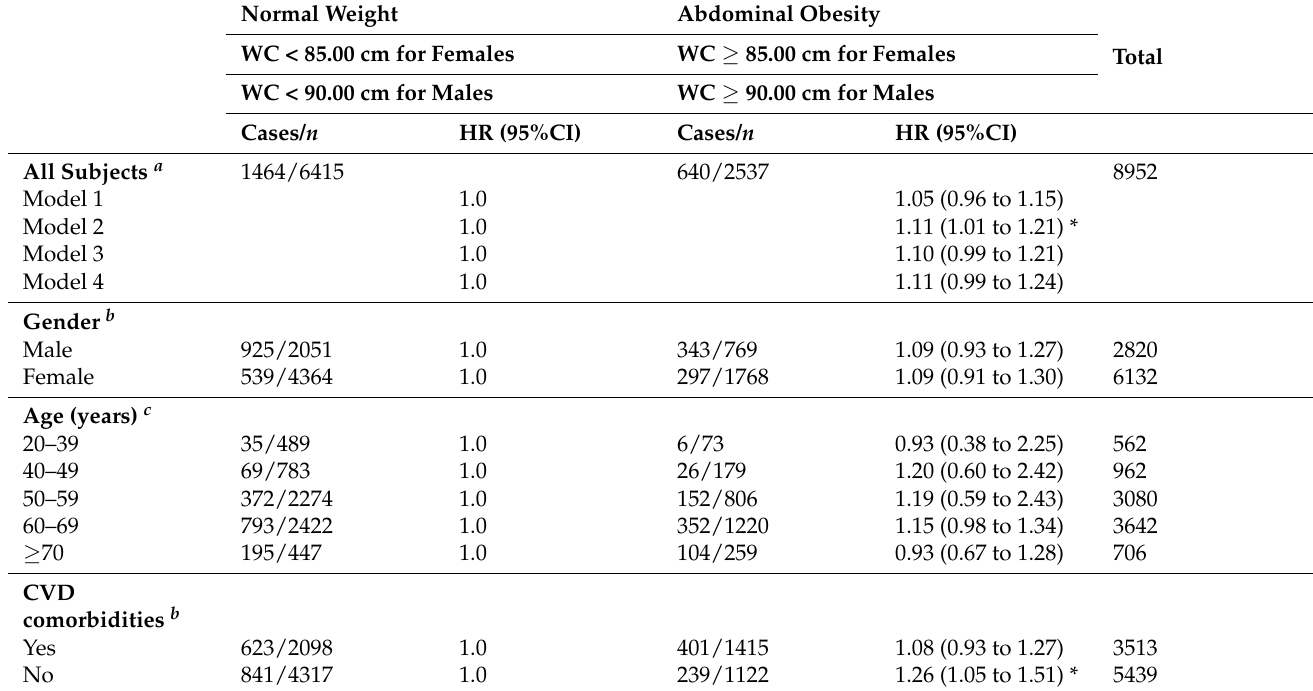
Table 3. Hazard ratios (HRs) and 95% confidence intervals (CIs) of HHcy according to Waist Circumference